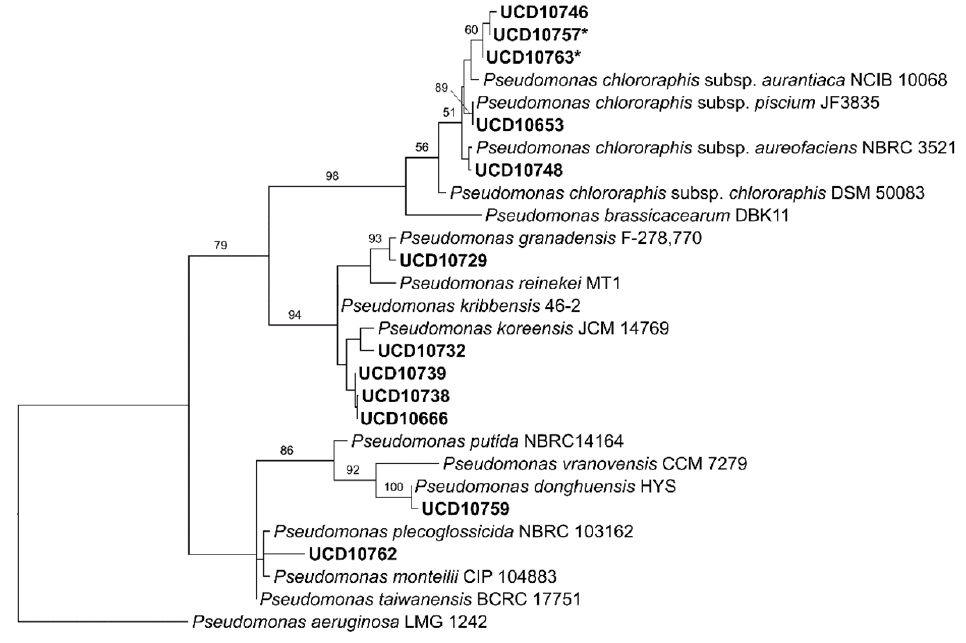
Figure 3. Most parsimonious phylogenetic analysis of 12 isolates of Pseudomonas spp. recovered from commercially grown various grapevine cultivars in California compared to closely related species. The tree was inferred with sequences of the 16S rDNA gene. Numbers above branches represent non-parametric bootstrap values from 1000 replicates. P. aeruginosa (LMG 1242) was used as outgroup. * = isolates used in dual antagonism assays and metabolites